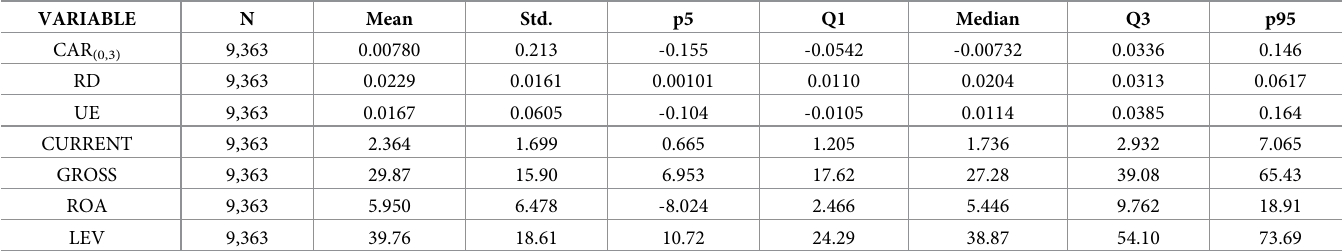
Table 2. Descriptive statistics of the main variables.